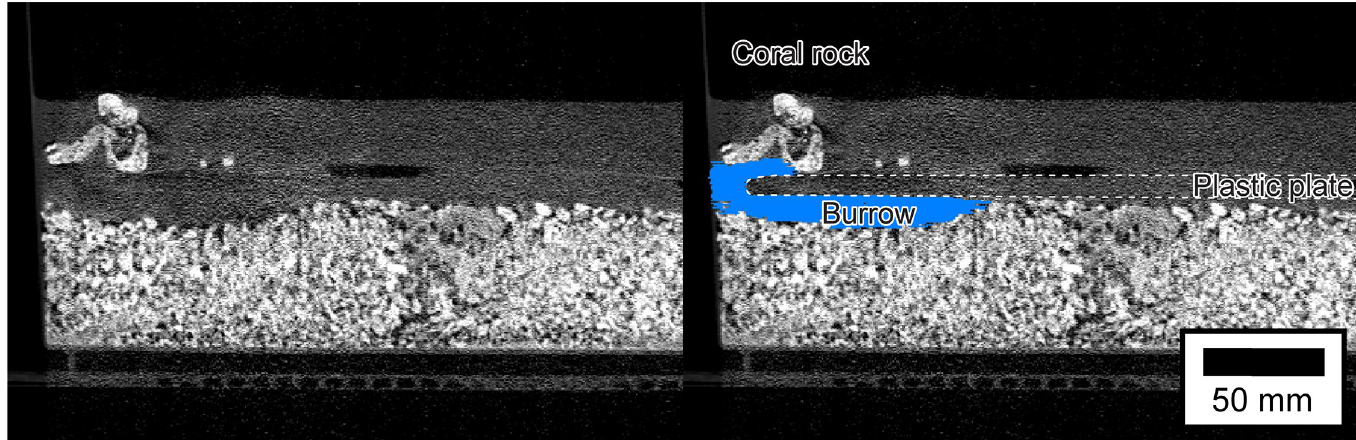
Fig 3. Cross section of an Alpheus bellulus burrow imaged by X-ray computed tomography. The blue shaded region in the right-hand panel shows the location of the burrow.